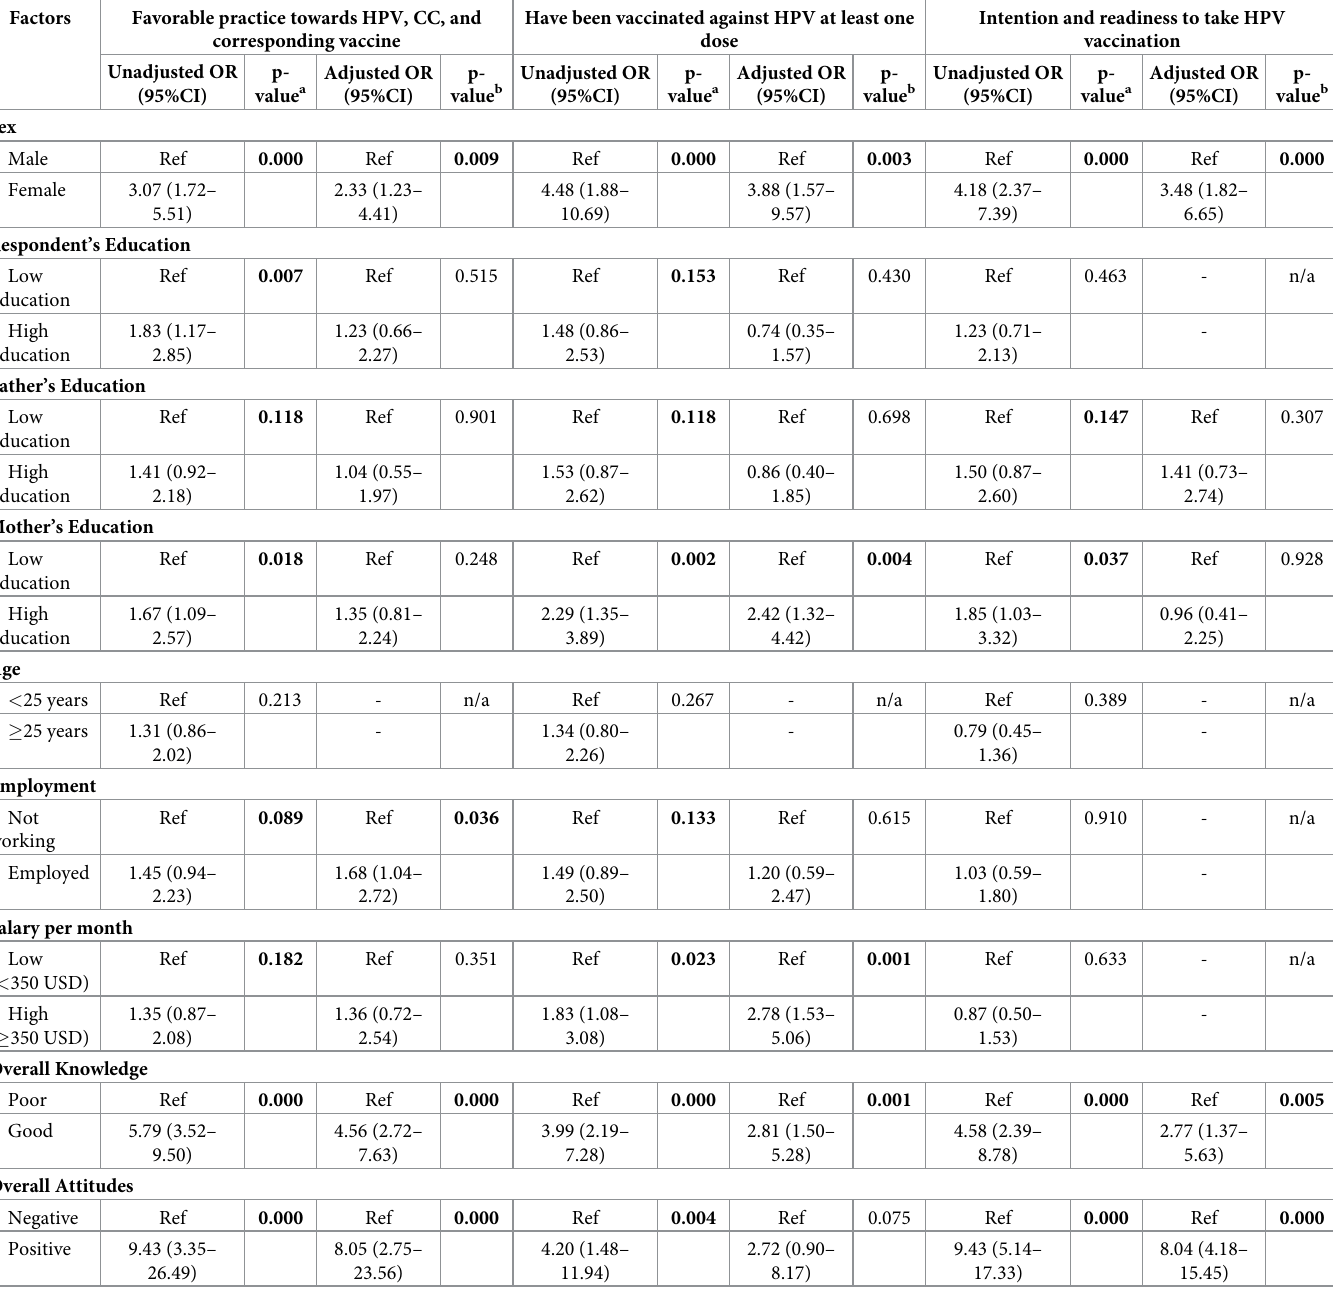
Table 5. Multivariate logistic regression model for factors favorable/appropriate practices and others related aspect of practices towards HPV, CC, and correspond- ing vaccine (N = 400). Factors